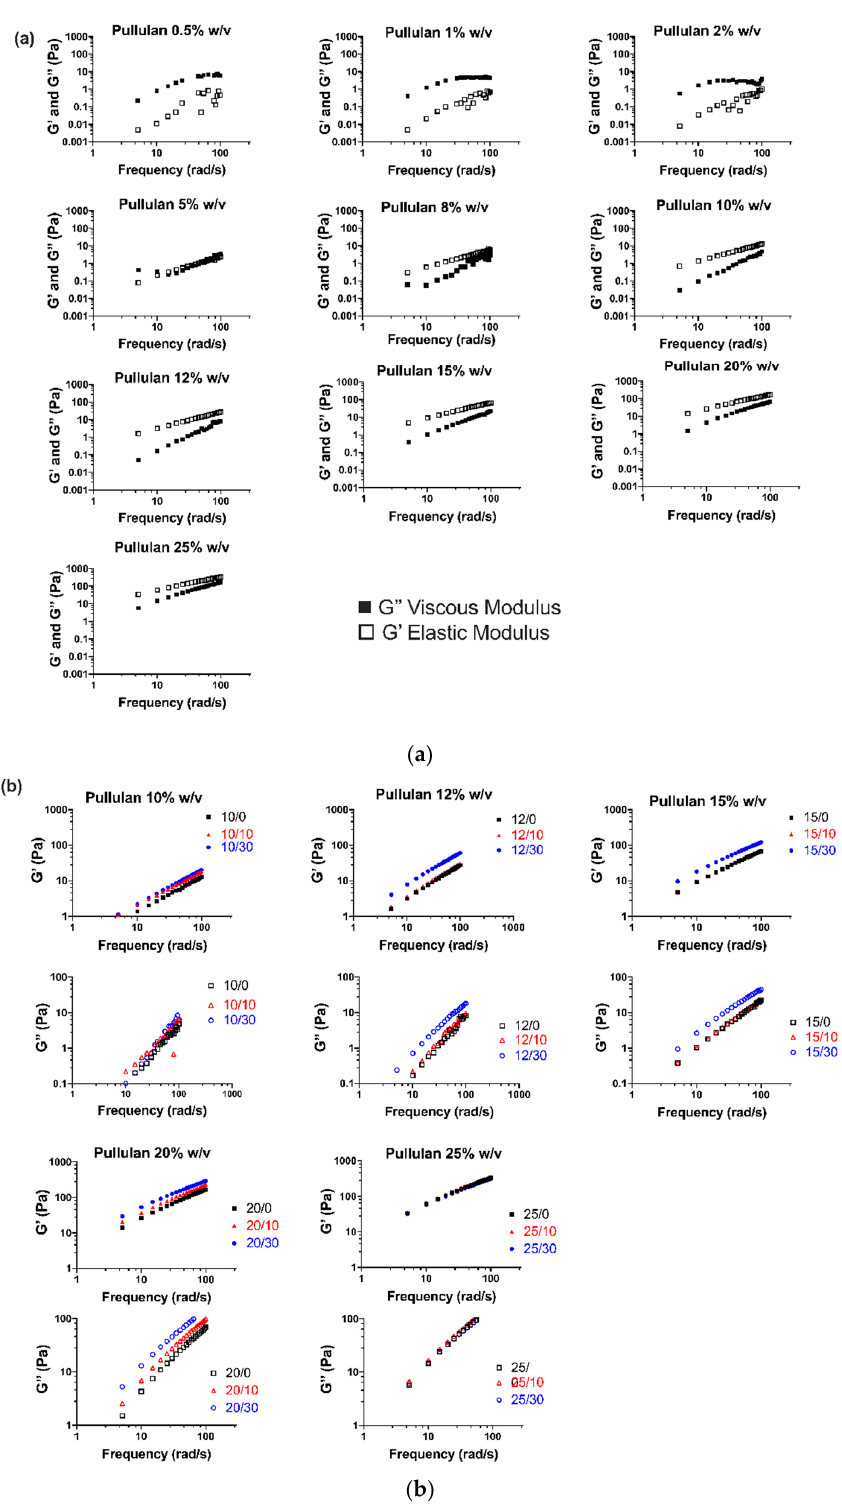
Figure 2. ( a ) Mechanical spectra of pullulan solutions at concentrations ranging 0.5–25% (w / v) showing the variation of elastic modulus, G’ (open symbols), and viscous modulus, G” (filled symbols), with frequency. ( b ) E ff ect of HP- β -CD (10 and 30% w / v) addition to pullulan solutions on the elastic modulus, G’, and viscous modulus,